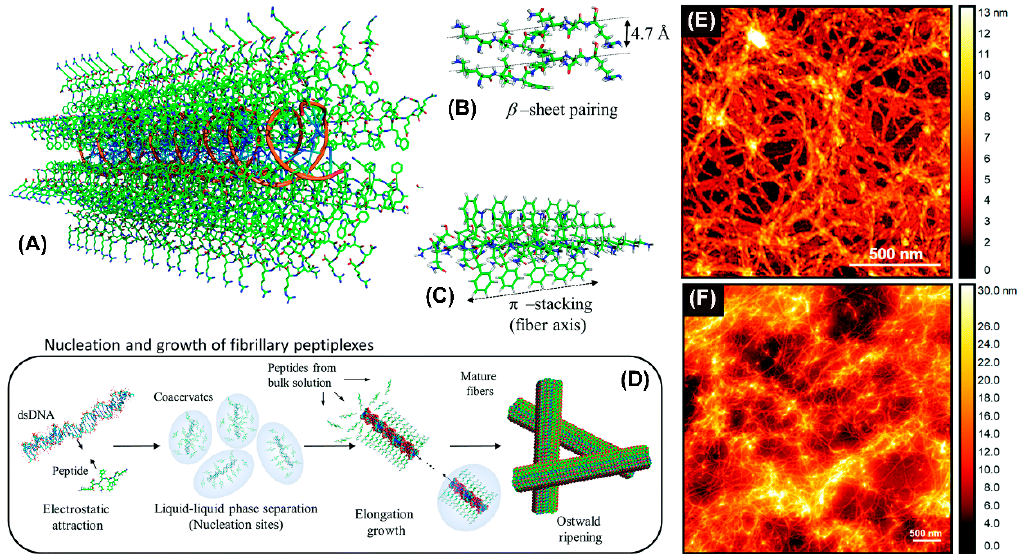
Figure 5. Schematic representation of the structural model proposed for complexation between KIW7 and DNA. ( A ) Fibrillary scaffold with a DNA core (orange ribbons) templating the growth of a peptide shell. ( B ) β -sheet paring between adjacent KIW7 chains in the fibers. ( C ) Supramolecular stacks formed by π - π interactions between phenylalanine and tryptophan. ( D ) Illustration of nucleation and growth of peptiplexes through liquid–liquid phase separation. AFM topography from KIW7 peptide complexed ( E ) with 200 bp DNA, and ( F ) with pDNA. Adapted and modified from [77], with permission. Copyright: 2020 Royal Society of Chemistry.